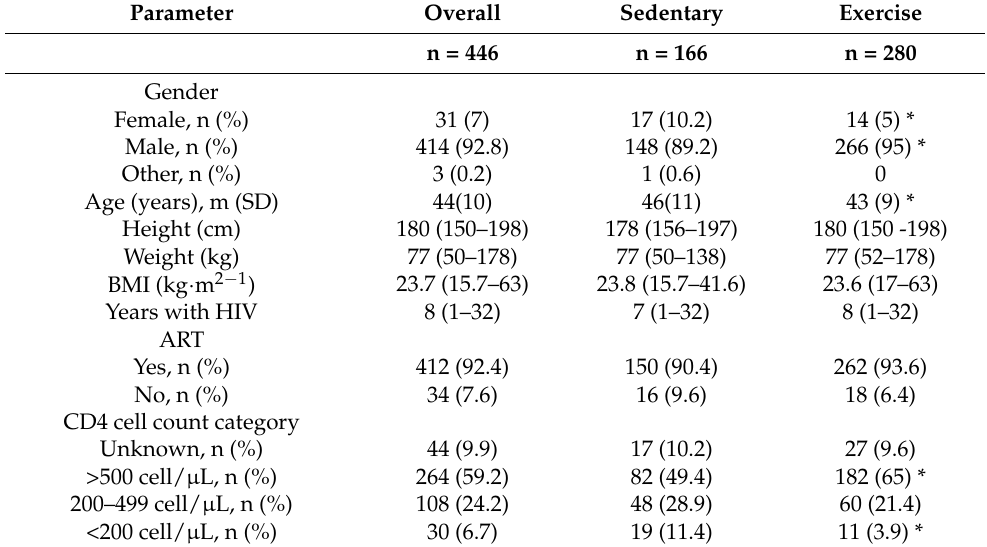
Table 1. Cohort characteristics.